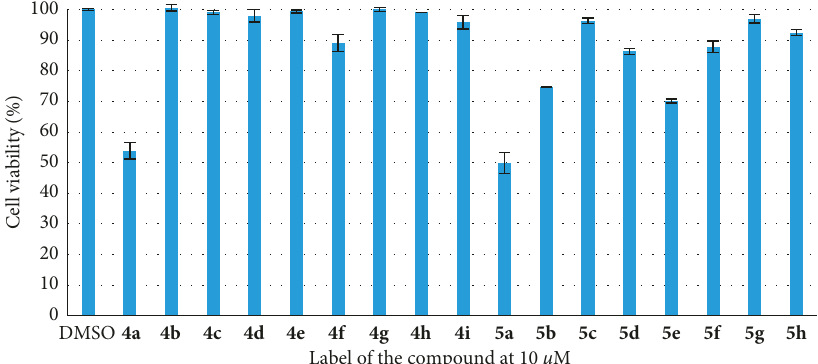
Figure 4: Anticancer activity 4a-i and 5a-h against colon cancer cells (HCT-116).